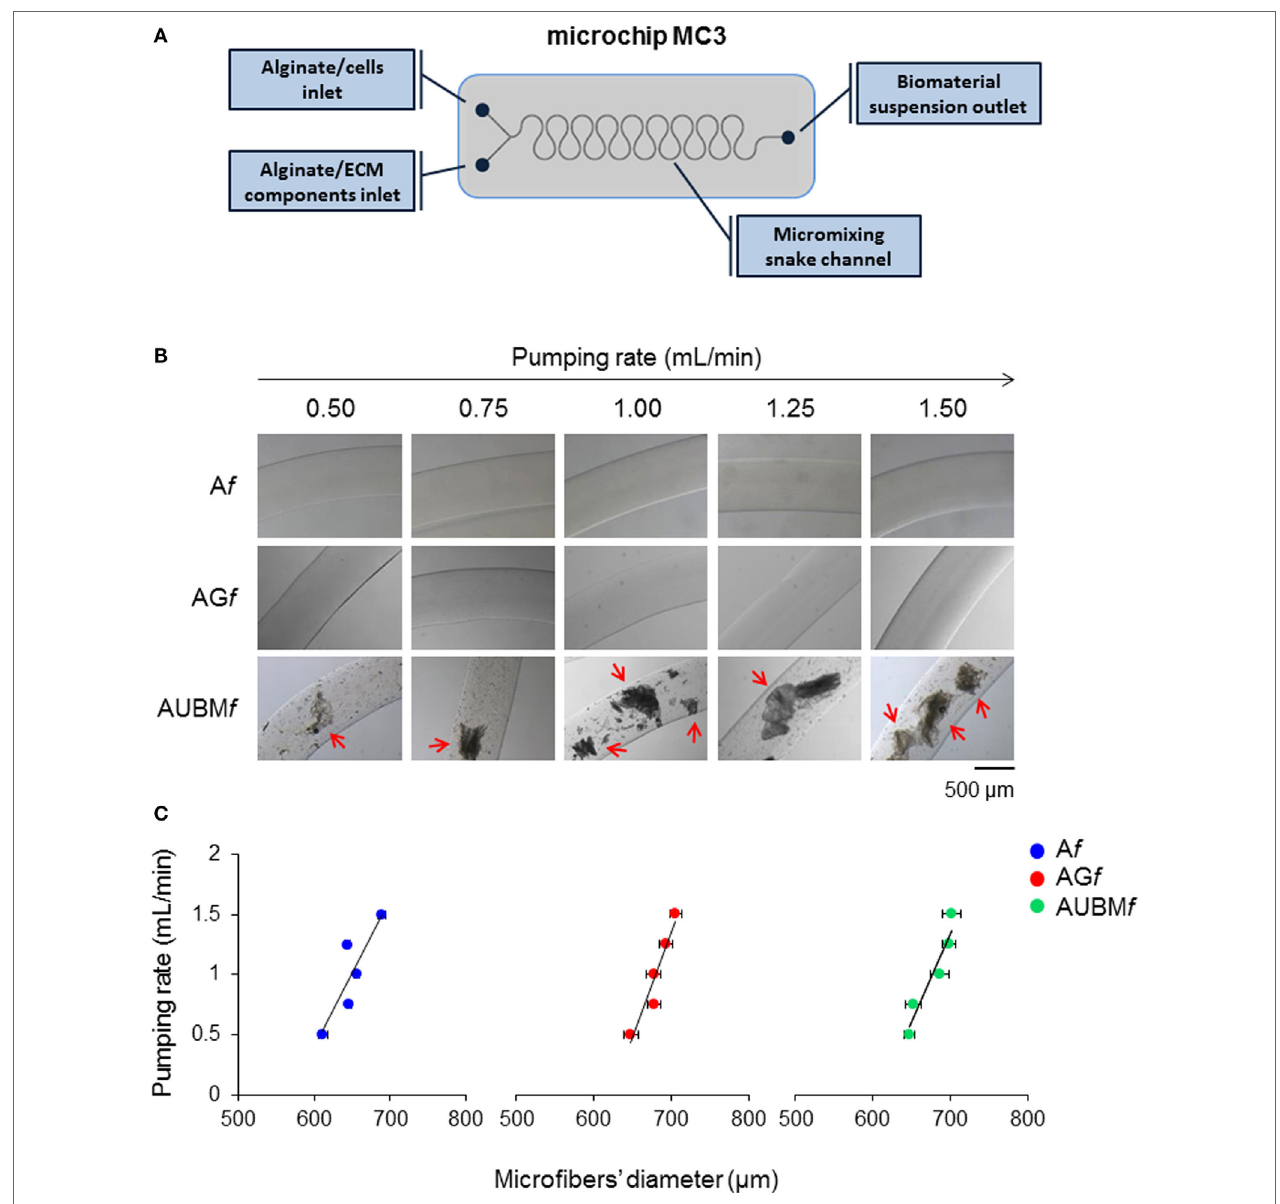
FigUre 1 | Production and characterization of composite microfibers. (a) Schematic representation of the snake micromixing microfluidic device employed for the production of composite microfibers. The device presents two inlets where the alginate suspension containing cells or gelatin or UBM were delivered through the micromixing snake geometry channel and a 700-µm outlet tube (#T3) into a BaCl 2 solution in order to obtain alginate (A f ), alginate plus gelatin (AG f ), or alginate plus UBM (AUBM f ) microfibers. (B) Photomicrographs of A f , AG f , and AUBM f obtained at different pumping rates (from 0.5 to 1.5 mL/min). Arrows indicate the presence in AUBM f of UBM particles, in form of flat flakes. Bar corresponds to 500 µm. (c) Effect of the pumping rate on the dimension of the produced microfibers.